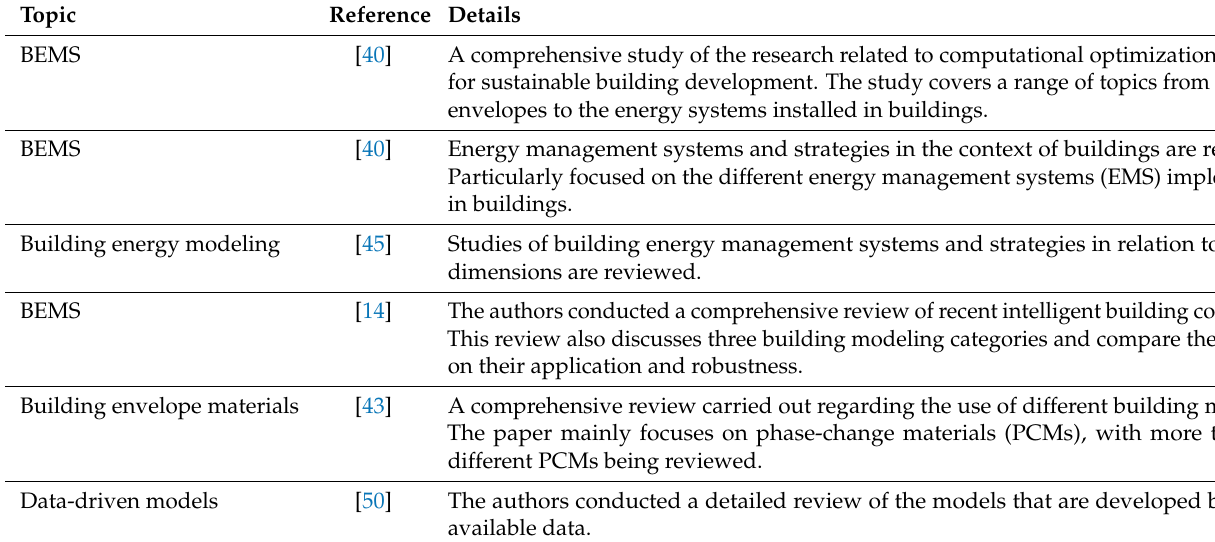
Table 1. State-of-the-art reviews related to building modeling and building energy management